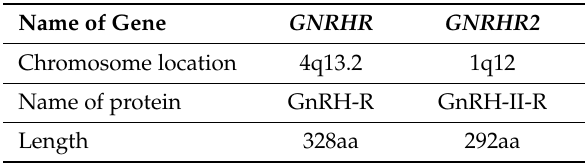
Table 1. Human Gonadotropin-releasing hormone (GnRH)